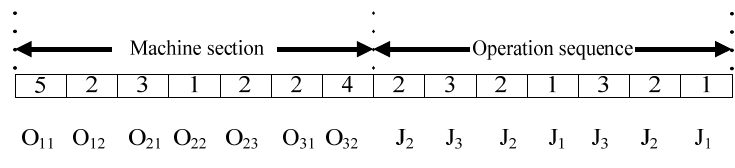
Figure 2. An example of the coding